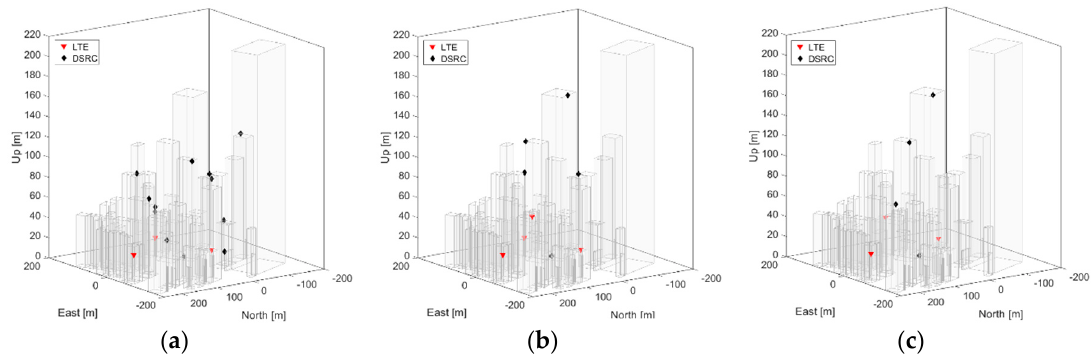
Figure 5. Resultant anchor locations satisfying 1, 2, and 3 m positioning accuracy (1 𝜎 ) are shown in ( a ), ( b ), and ( c ), respectively. ( a ) has a total of 15 ranging sources, ( b ) has a total of nine ranging sources, and ( c ) has seven ranging sources.